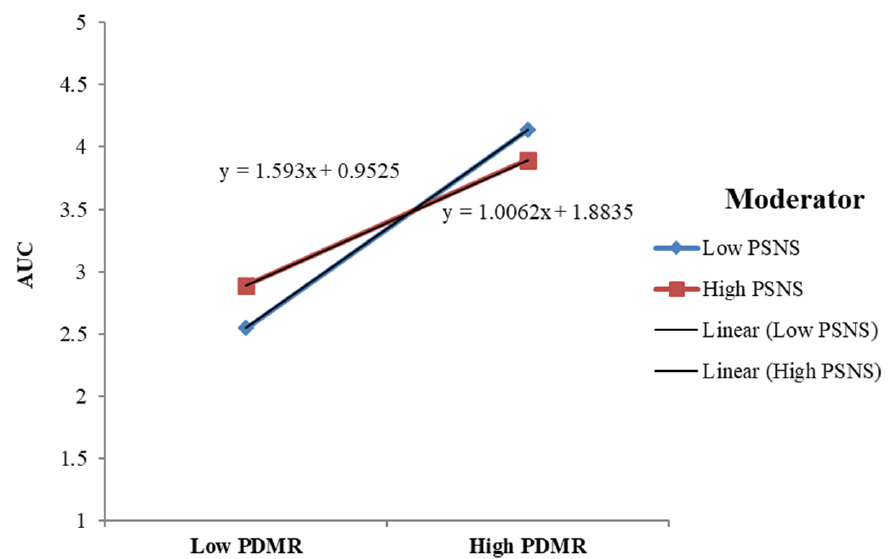
Figure 4. PSNS’s high and low effects on AUC through PDMR.